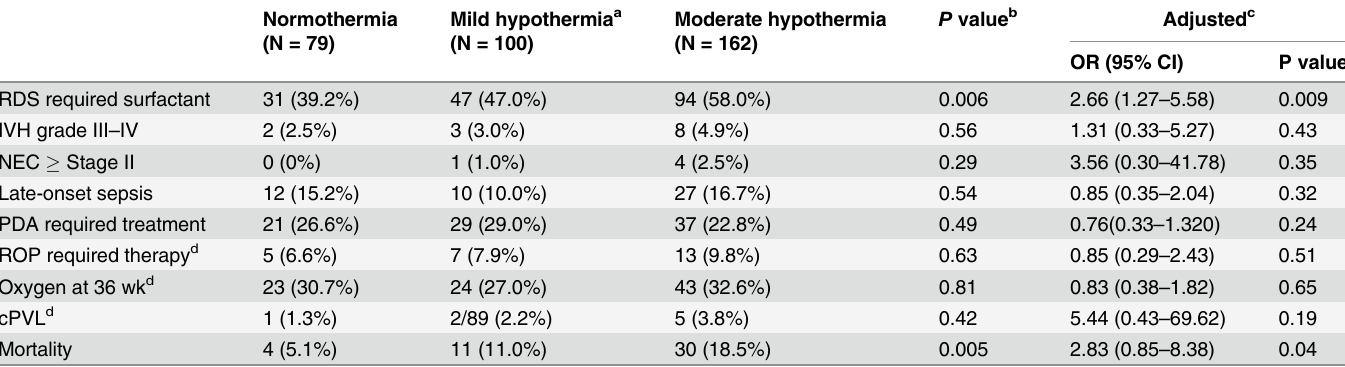
Table 2. Short-term outcomes between